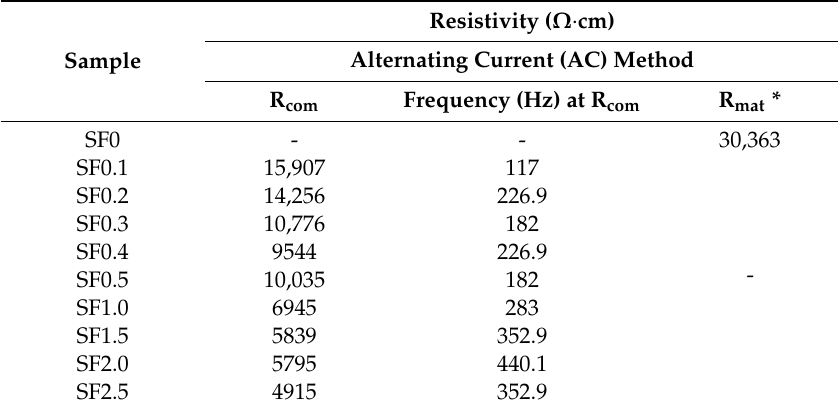
Table 5. Resistivity of HPFRCC with various amounts of steel fiber.